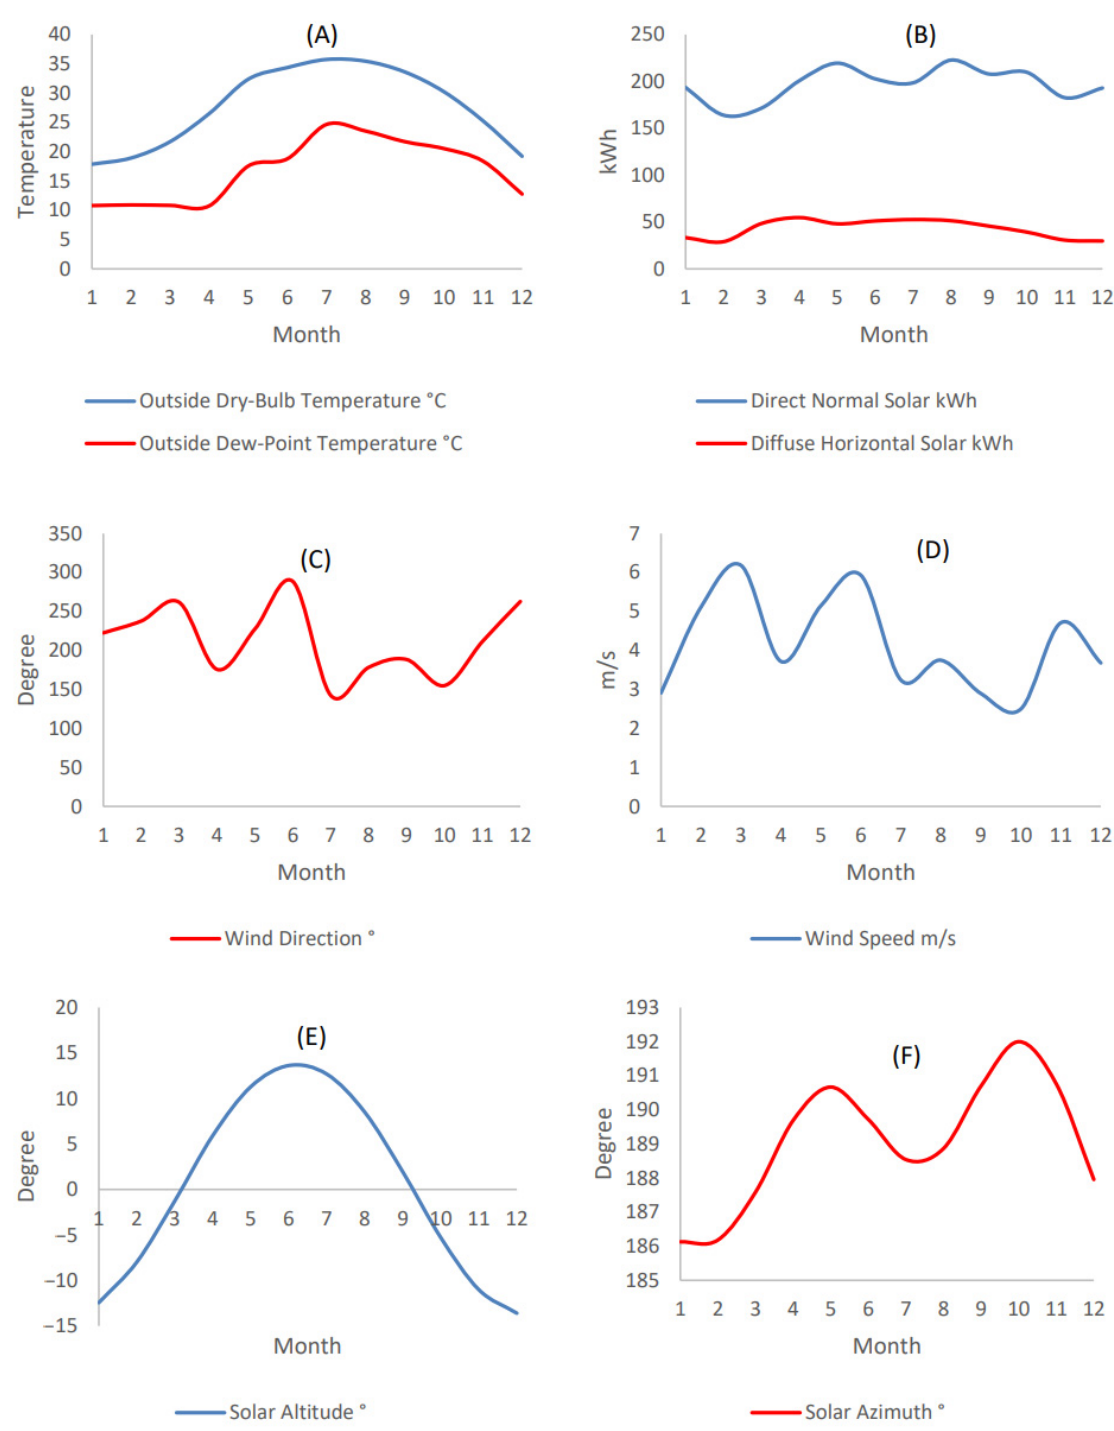
Figure 2. Site weather data (Doha-Qatar). ( A ) Outside dry-bulb and dew-point temperatures; ( B ) Direct normal and diffusive horizontal solar intensity; ( C ) Wind direction; ( D ) Wind speed; ( E ) Solar altitude; ( F ) Solar azimuth.